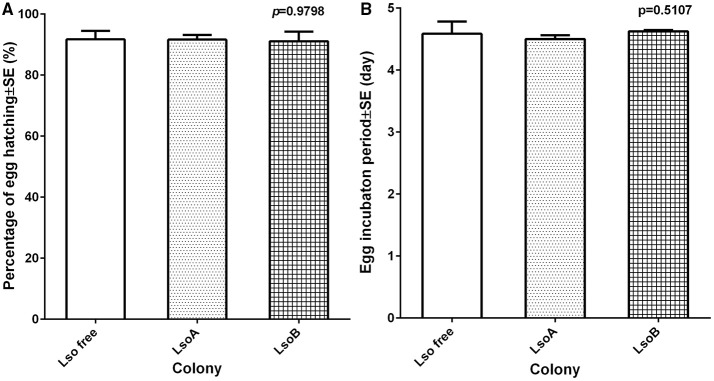
Egg viability and average incubation time of each psyllid colony under different haplotype infection. (A) The percentage of egg hatch was defined as the number of nymphs hatched out of the total number of eggs deposited. Each bar represents the mean and standard error of the percentage of egg hatching of n = 6 experimental replicates. (B) The egg incubation time was referred to the time period between the first oviposition and the appearance of first nymph. Each bar represents the mean and standard error of the egg incubation period in days of n = 6 experimental replicates.